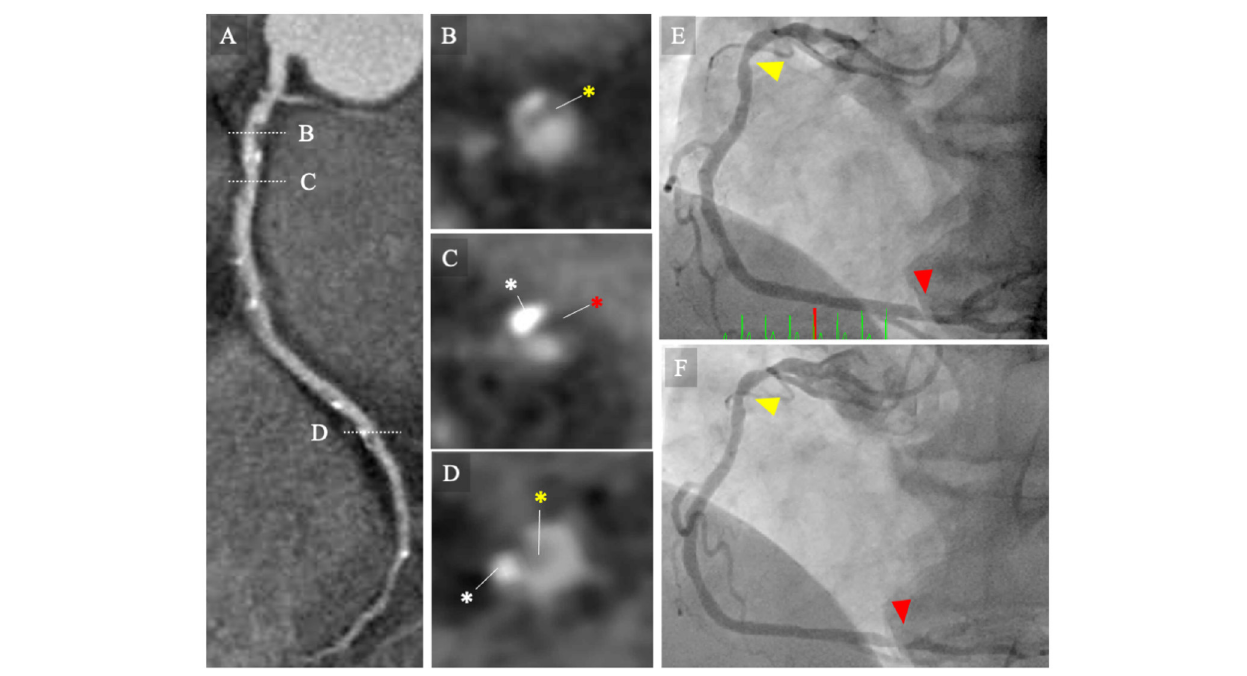
FIGURE 2 | CCTA images and invasive coronary angiography. (A–D) CCTA images of a patient with non-obstructive CAD and increased low-attenuation plaque (Q4) who developed to unstable angina requiring urgent coronary revascularization. The MPR image of the baseline CCTA image for right coronary artery (RCA) showing intermediate stenosis severity with low-attenuation coronary plaque (Q4). (B–D) Cross-sectional images of coronary lesions (white broken bars). (B) Mild stenosis with non-calcified plaque (yellow asterisk). (C) Intermediate stenosis with calcified plaque (white asterisk) and low-attenuation plaque (red asterisk). (D) Intermediate stenosis with calcified and non-calcified plaques. (E) Invasive coronary angiography performed at 12 days following the baseline CCTA examination. Invasive coronary angiography (ICA) image shows intermediate stenosis of the proximal (yellow arrowhead) and distal portions of the RCA (red arrowhead). The patient was managed with conservative strategy, including statins. (F) The patient presented with unstable angina and underwent emergency ICA at 1.5 years following the baseline CCTA examination. The ICA image revealed progression of the coronary lesions (red arrowheads). CCTA, coronary computed tomography angiography; ICA, invasive coronary angiography; MPR, multi-planar reconstruction; RCA, right coronary